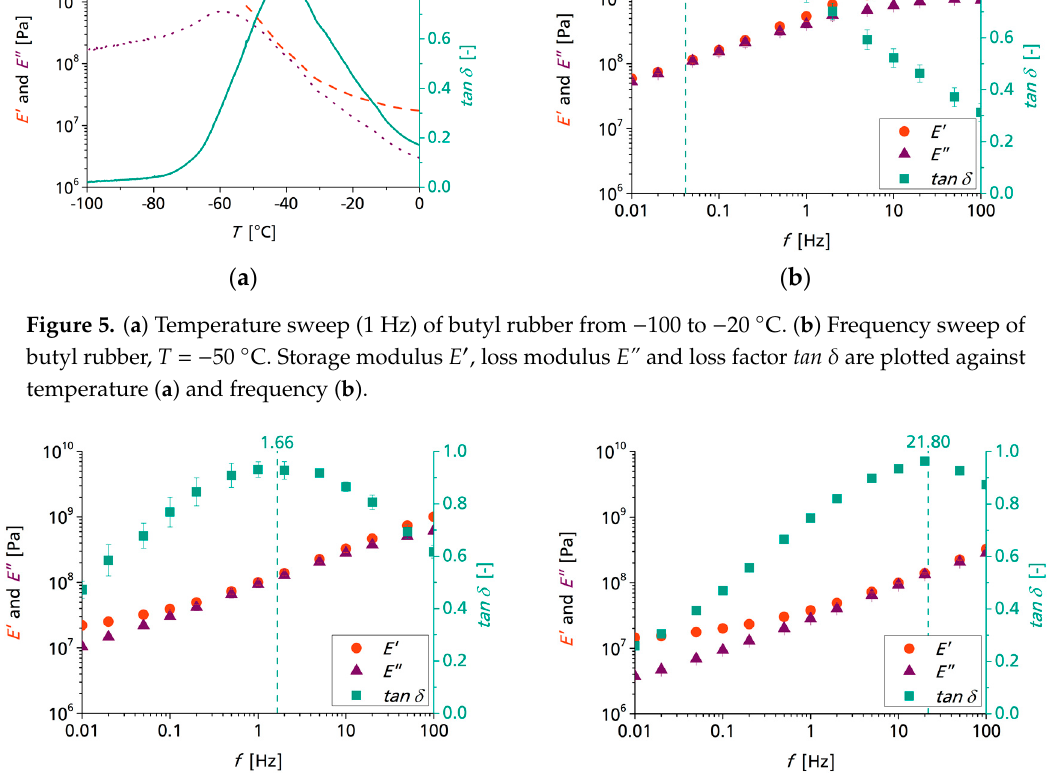
Figure 6. Frequency sweeps of butyl rubber: ( a ) T = − 40 °C and ( b ) T = − 30 °C. Storage modulus E ′ , loss modulus E ″ and loss factor tan δ are plotted against frequency.